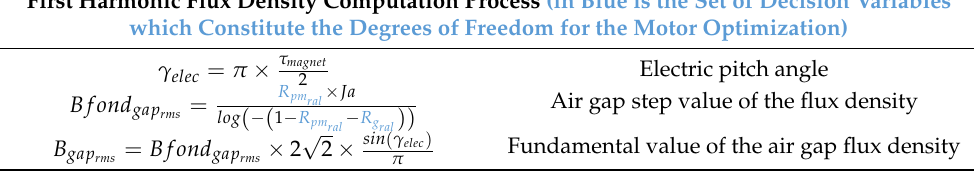
Table 2. First harmonic flux density computation